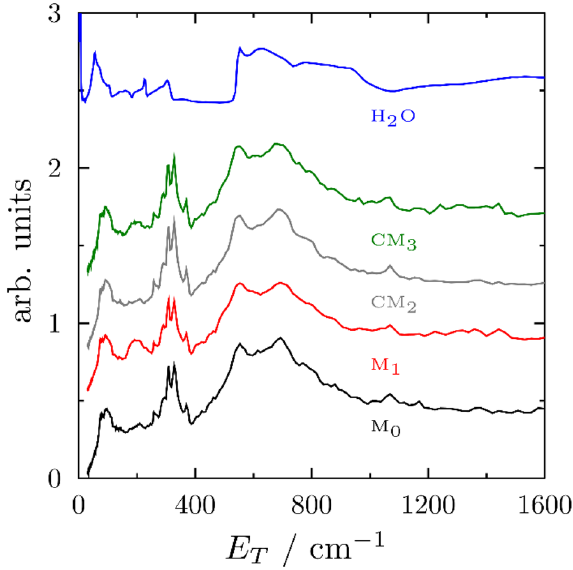
Figure 1. Experimental INS spectra of M 0 (black); M 1 (red); CM 2 (grey); CM 3 (green); and bulk H 2 O (blue). Spectra have been scaled and shifted vertically to ease visualization and